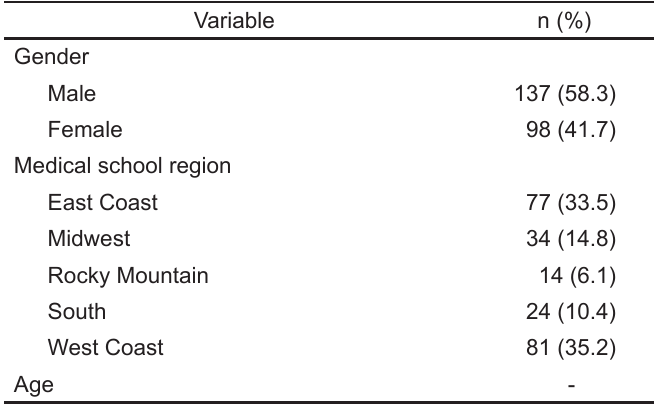
Table 1. Demographics of surveyed applicants with regard to interview dress code (mean age